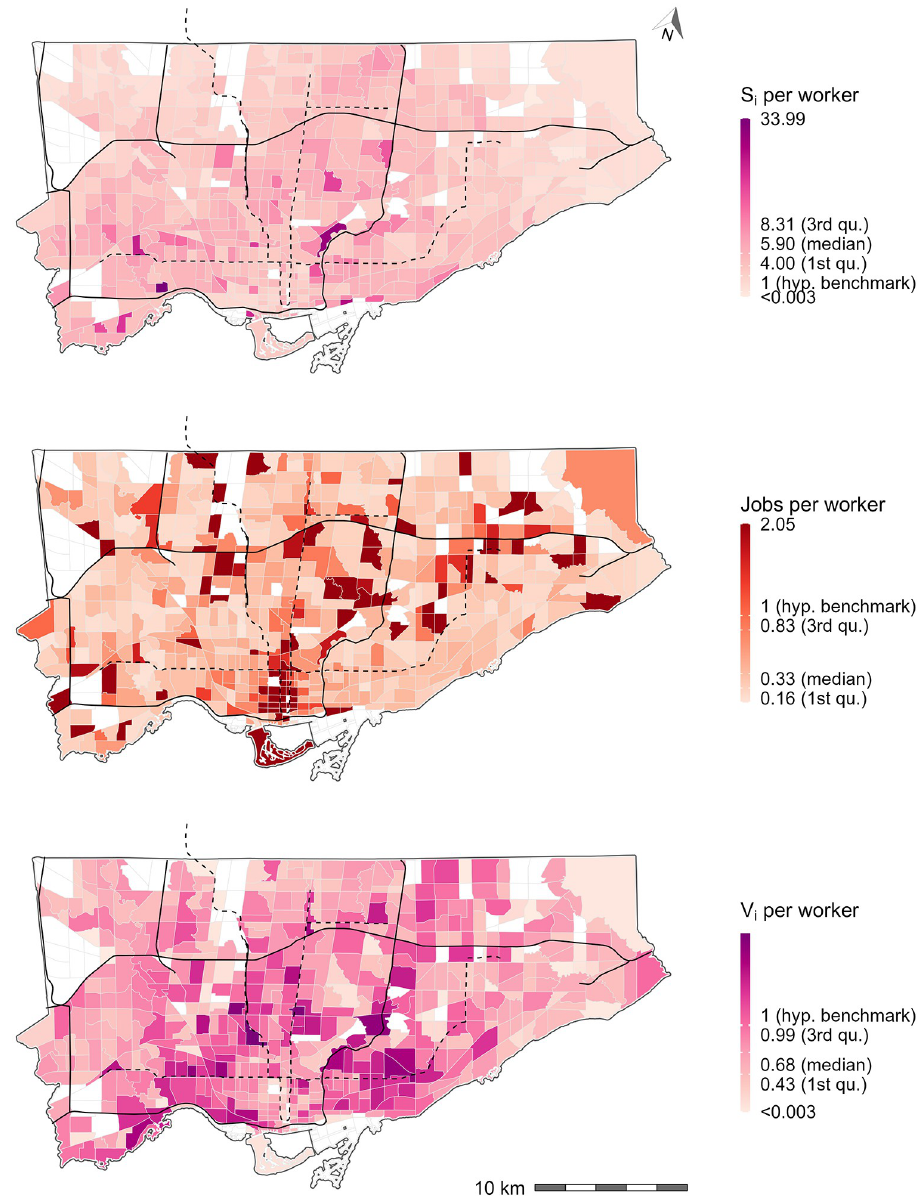
Fig 9. Hansen-type accessible jobs per capita (top), number of jobs to population ratio (middle), and spatially available jobs per capita (bottom) for Toronto. An arbitrary jobs-to-workers ratio is assumed to be 1 in the paper, this is the hypothetical opportunity availability benchmark. Black lines represent expressways and black dashed lines represent subway lines. All white TAZ have no worker population or jobs, i.e., with null accessibility